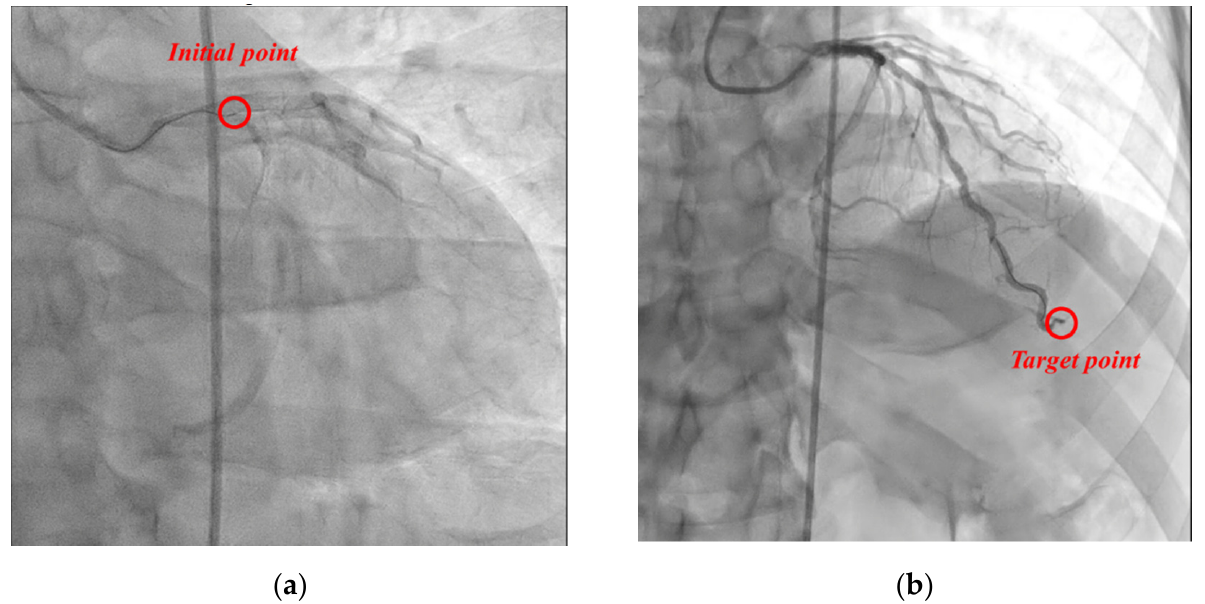
Figure 18. Angiographic views of the left coronary artery of patient 1. ( a ) The guidewire was located at the entrance of coronary. ( b ) The guidewire was located at target point.